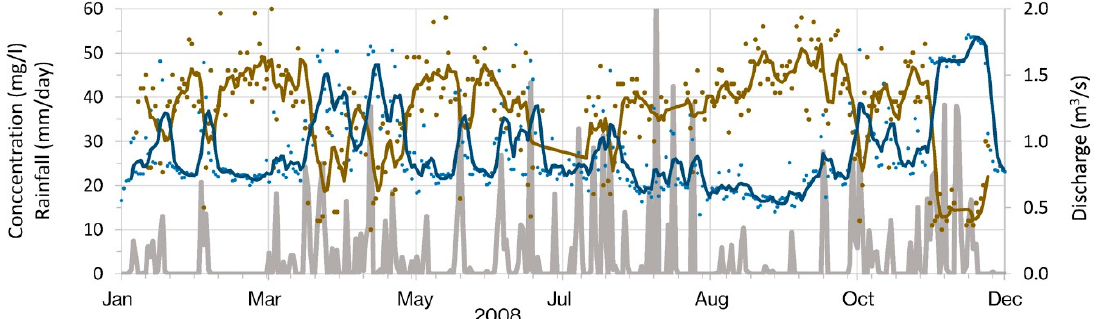
Figure 4. Concentration of total nitrogen at wastewater treatment plant (WWTP) presented with brown dots and 5 days moving average (brown line), discharge presented with blue dots and 5 days moving average (blue line), and rainfall high (gray line) measured at Ljubljana Bežigrad weather station (year 2008).